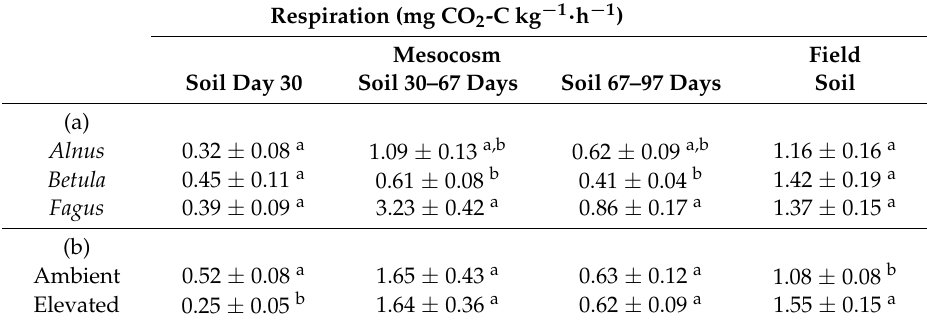
Table 4. Effects of ( a ) litter species and ( b ) CO 2 regime on respiration in soil aggregates from mesocosm and field experiments.